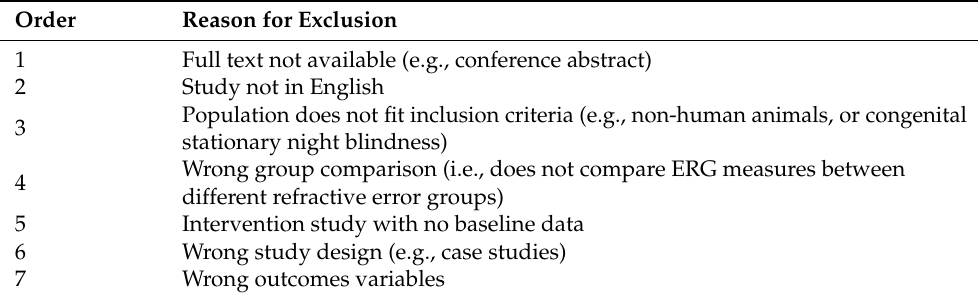
Table 2. Hierarchy of Exclusion Reasons for Full-Text Screening.